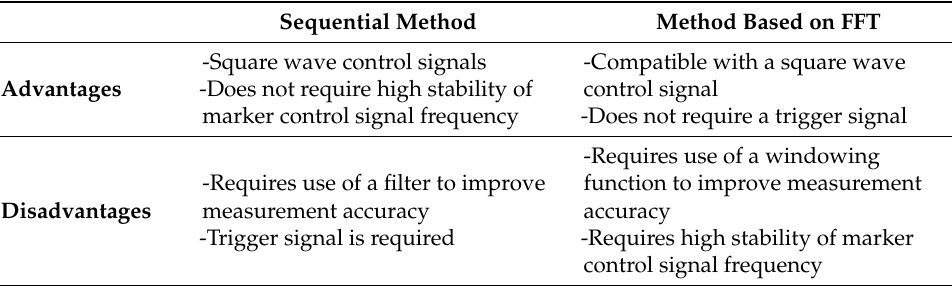
Table 8. Market control method